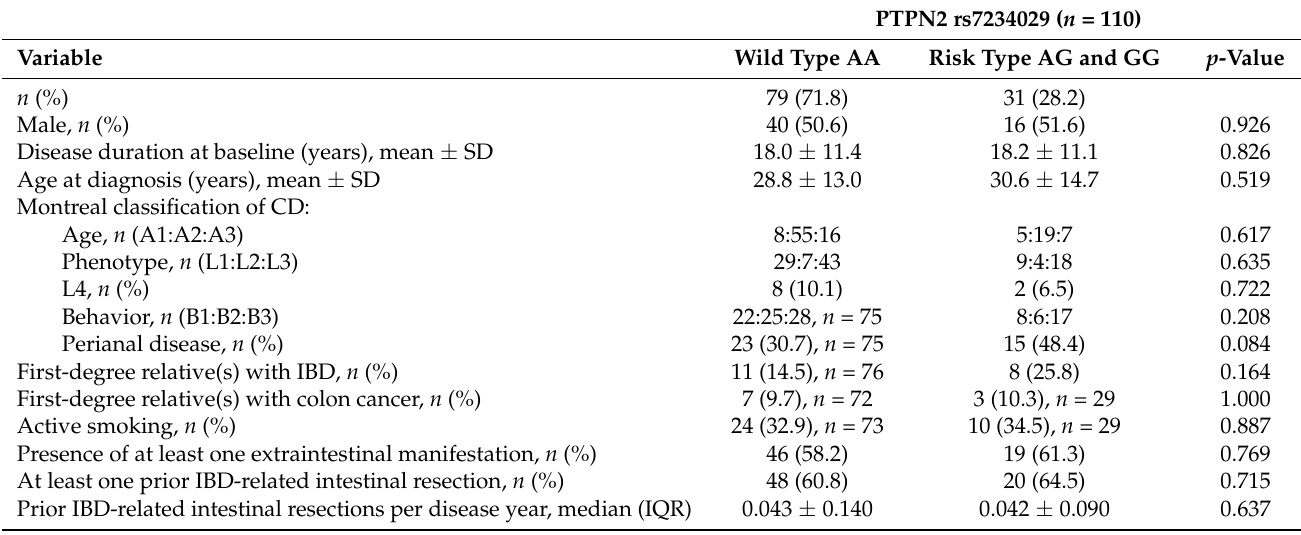
Table 4. Baseline characteristics in 110 CD patients treated with anti-interleukin-12/23 according to PTPN2 rs7234029